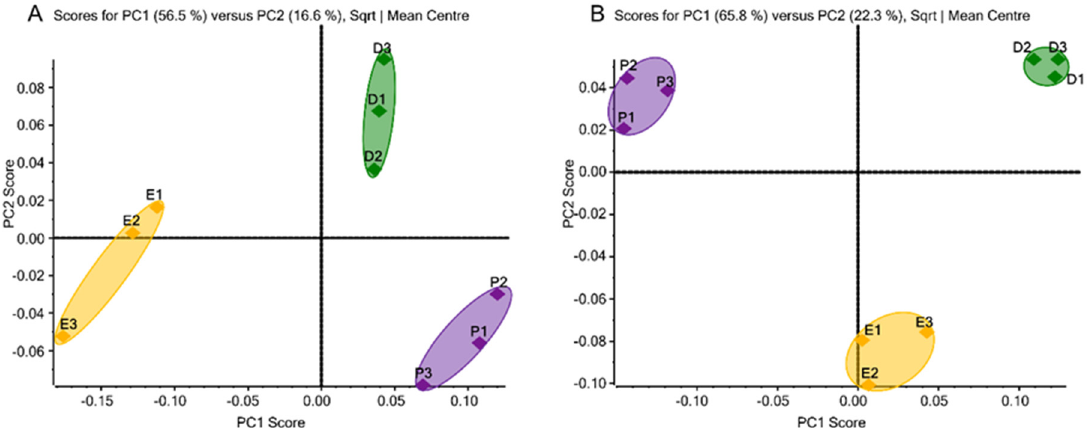
Figure 1. Unsupervised principal component analysis of N -glycans derived from ( A ) the 231BR cell line, with 49 glycans, 48 glycans, and 50 glycans identified in DMEM, EMEM, and Plasmax, respectively, and ( B ) the CRL cell line, with 50 glycans identified in each of the three media. Symbols: , DMEM; , EMEM; , Plasmax.